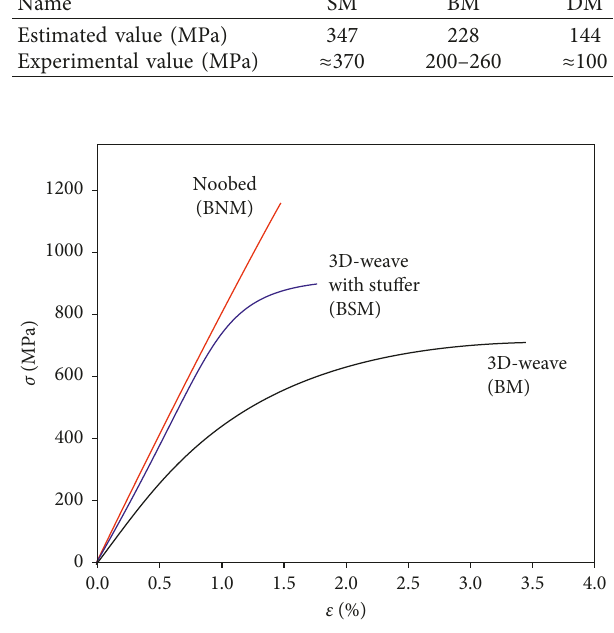
Figure 8: The principal stress vs. strain response of specimens with noobed (BNM) reinforcement and 3D-woven reinforcement with stuffer yarns (BSM). The principal response of a specimen rein- forced with a plain 3D weave (BM) is added for comparison. The curves are valid for interior RVEs since all specimens were milled.